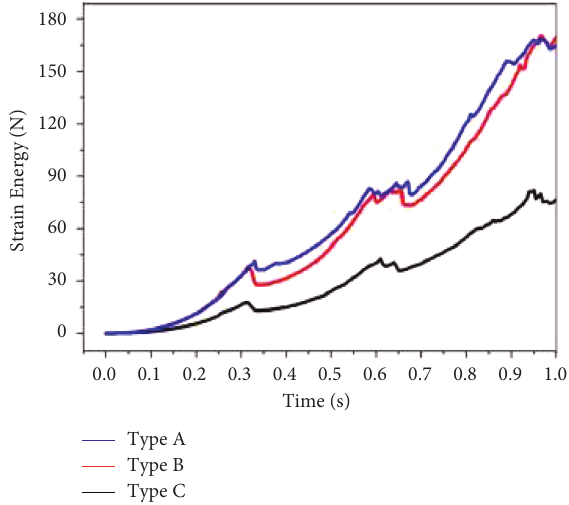
Figure 10: Strain energy-time history curve of